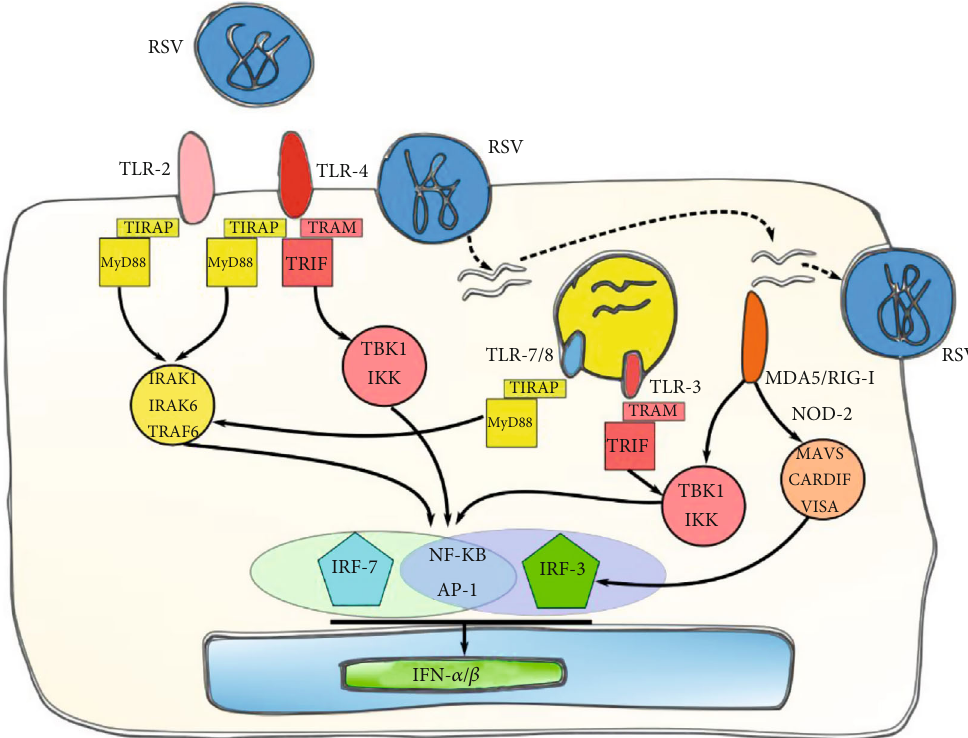
Figure 4: Induction of IFN-I by RSV. RSV is detected by di ff erent PRRs that include TLR-2, TLR-4, TLR-3, TLR-7/8, MDA5, and RIG-I and leads to the IFN-I pathway